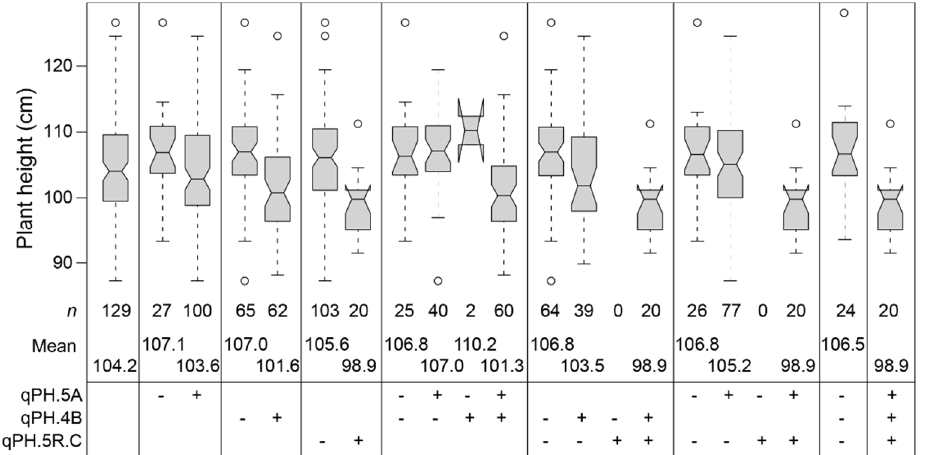
Figure 4. Effects of the QTL detected on chromosomes 5A, 4B, and 5R as well as their combinations on plant height, assessed in the 129 registered cultivars. ‘+‘ and ‘-’ indicate presence or absence of the height-reducing QTL alleles. If no presence/absence labeling is shown, the allelic state of the respective QTL was not considered.